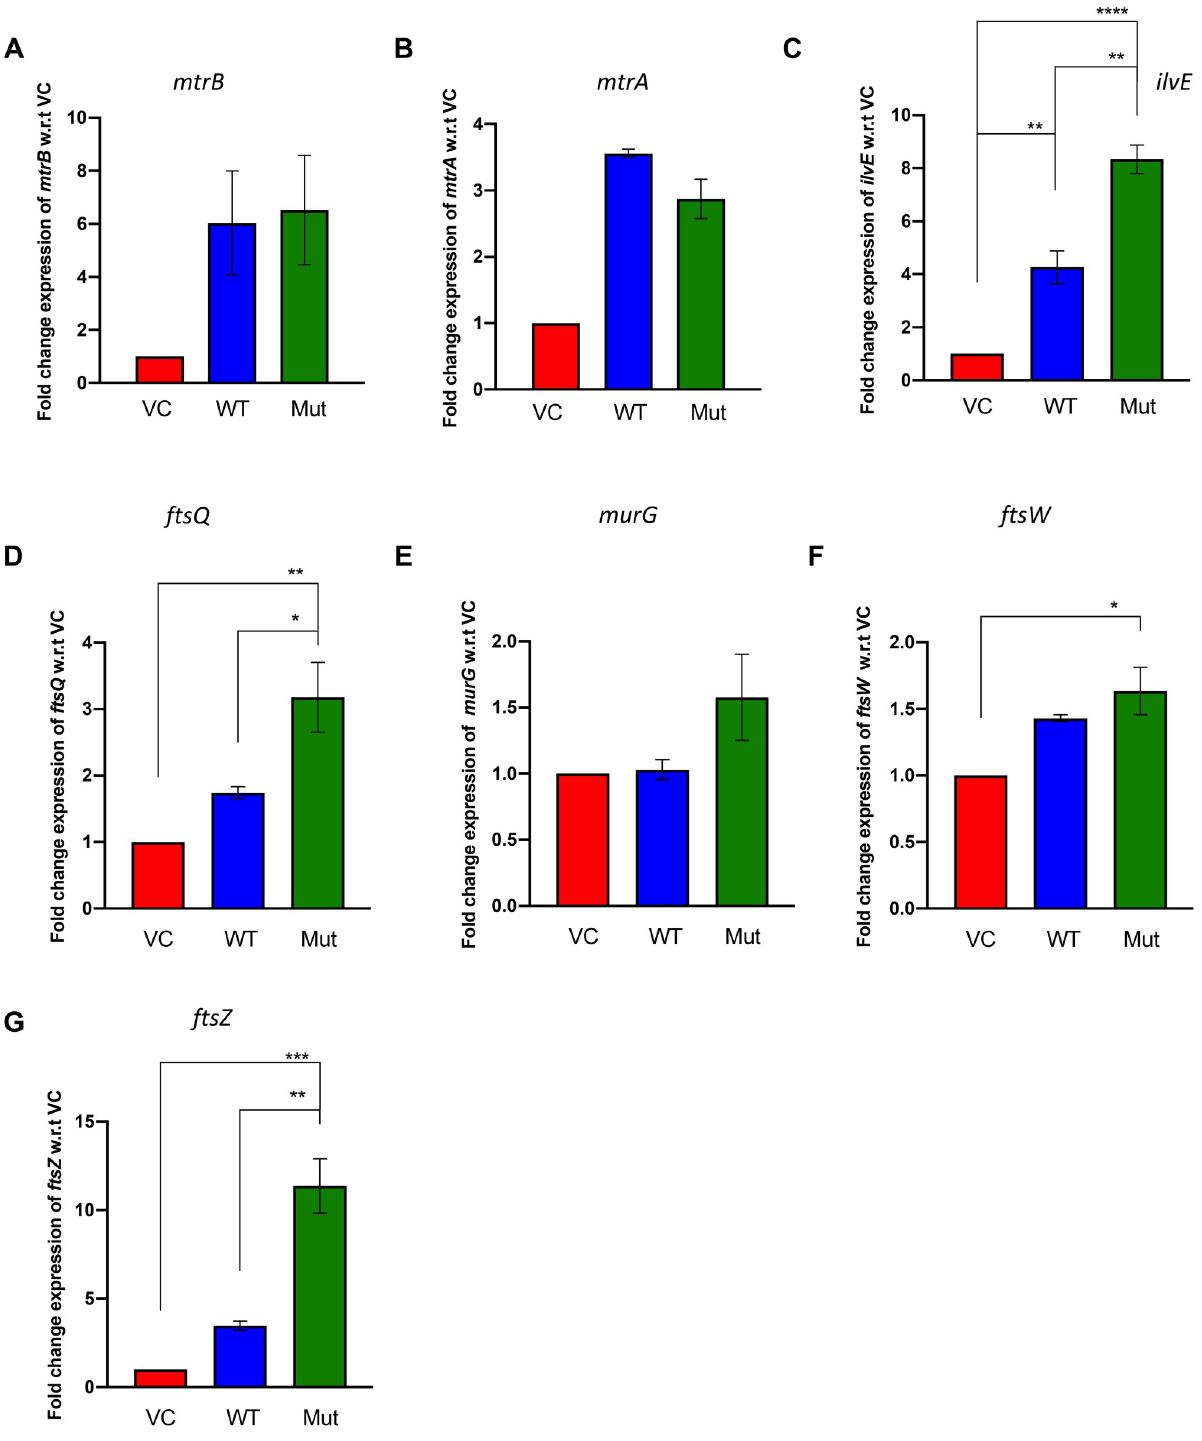
Fig 4. Assessment of the impact of MtrB mutation on downstream gene expression in M . tuberculosis H37Ra . A-G. Relative expression of mRNA levels in H37Ra strains over-expressing the wild-type or mutant mtrB cloned in the pMV261 vector and grown in Middlebrook 7H9 medium. The expression of the specific genes was normalized to the levels of 16S rRNA before calculating the fold change between test and vector control samples. The expression changes are shown for the A. mtrB ; B. mtrA ; C. ilvE ; D. ftsQ ; E. murG ; F. ftsW ; G. ftsZ . For all experiments, n = 3 biologically independent experiments. ( p values; � � 0.05, �� � 0.01, ��� � 0.001, ���� � 0.0001).